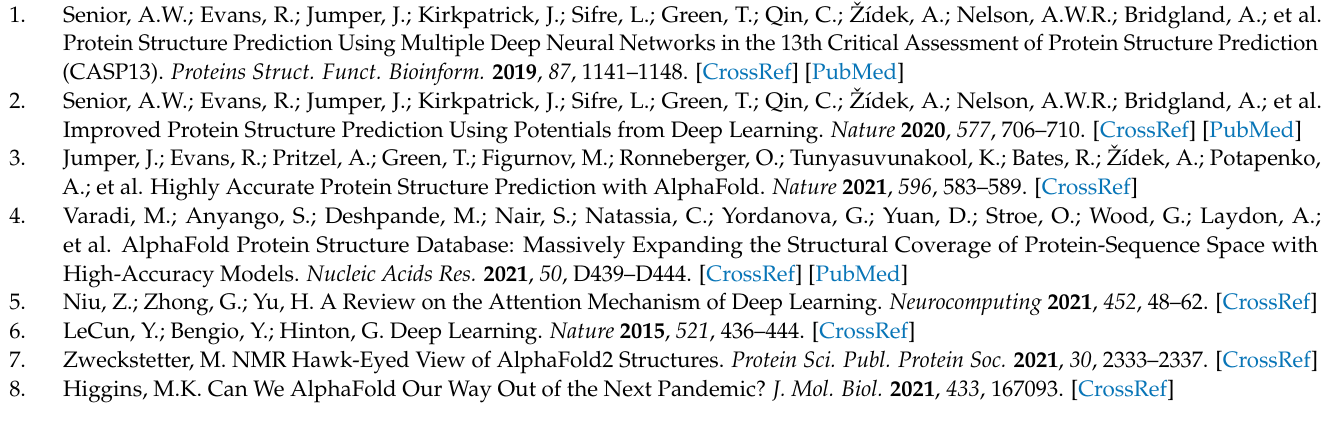
Figure S2. The names and sequences of the fusion proteins, whose 3D models were used in the study. Figure S3. Quality evaluation of the AlphaFold2-built 3D models of the fusion proteins presented as a per-residue confidence score (pLDDT). Figure S4. Sequences of the fusion proteins with color mapping of binding interfaces on the representative structures of the lowest energy clusters were obtained for the best 30 HADDOCK-generated Gal4BD-MBP/Gal4AD-Bri23R complexes. Figure S5. Sequences of the fusion proteins with color mapping of binding interfaces on the representative structures of the lowest energy clusters were obtained for the best 30 HADDOCK-generated Gal4AD- MBP/Gal4BD-Bri23R complexes. Figure S6. Sequences of MBP and Bri23R with color mapping of binding interfaces on the representative structures of the lowest energy clusters were obtained for the best 30 HADDOCK-generated MBP/Bri23R complexes. Table S1. Unique clones were identified by means of a two-hybrid yeast system. Table S2. Polar interactions in the intermolecular interfaces of the representative structures of the lowest energy clusters were obtained for the best 30 HADDOCK- generated Gal4BD-MBP/Gal4AD-Bri23R complexes. Table S3. Polar interactions in the intermolecular interfaces of the representative structures of the lowest energy clusters were obtained for the best 30 HADDOCK-generated Gal4AD-MBP/Gal4BD-Bri23R complexes. Table S4. The solvation free energy and polar interactions of the intermolecular interfaces of the representative structures of the lowest energy clusters were obtained for the best 30 HADDOCK-generated MBP/Bri23R